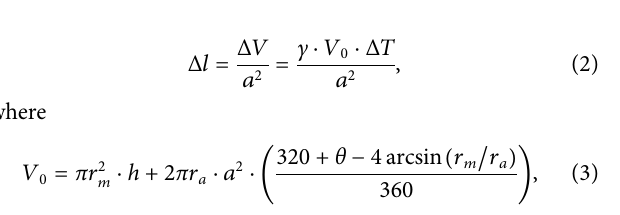
Frontiers in Materials |